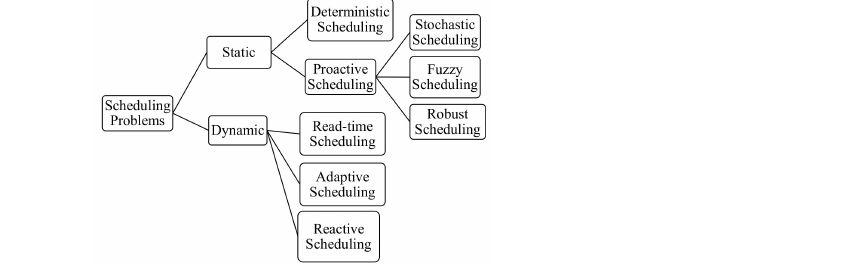
Figure 6. Lin, Gen [88] classification of scheduling problems based on their processing characteristics.